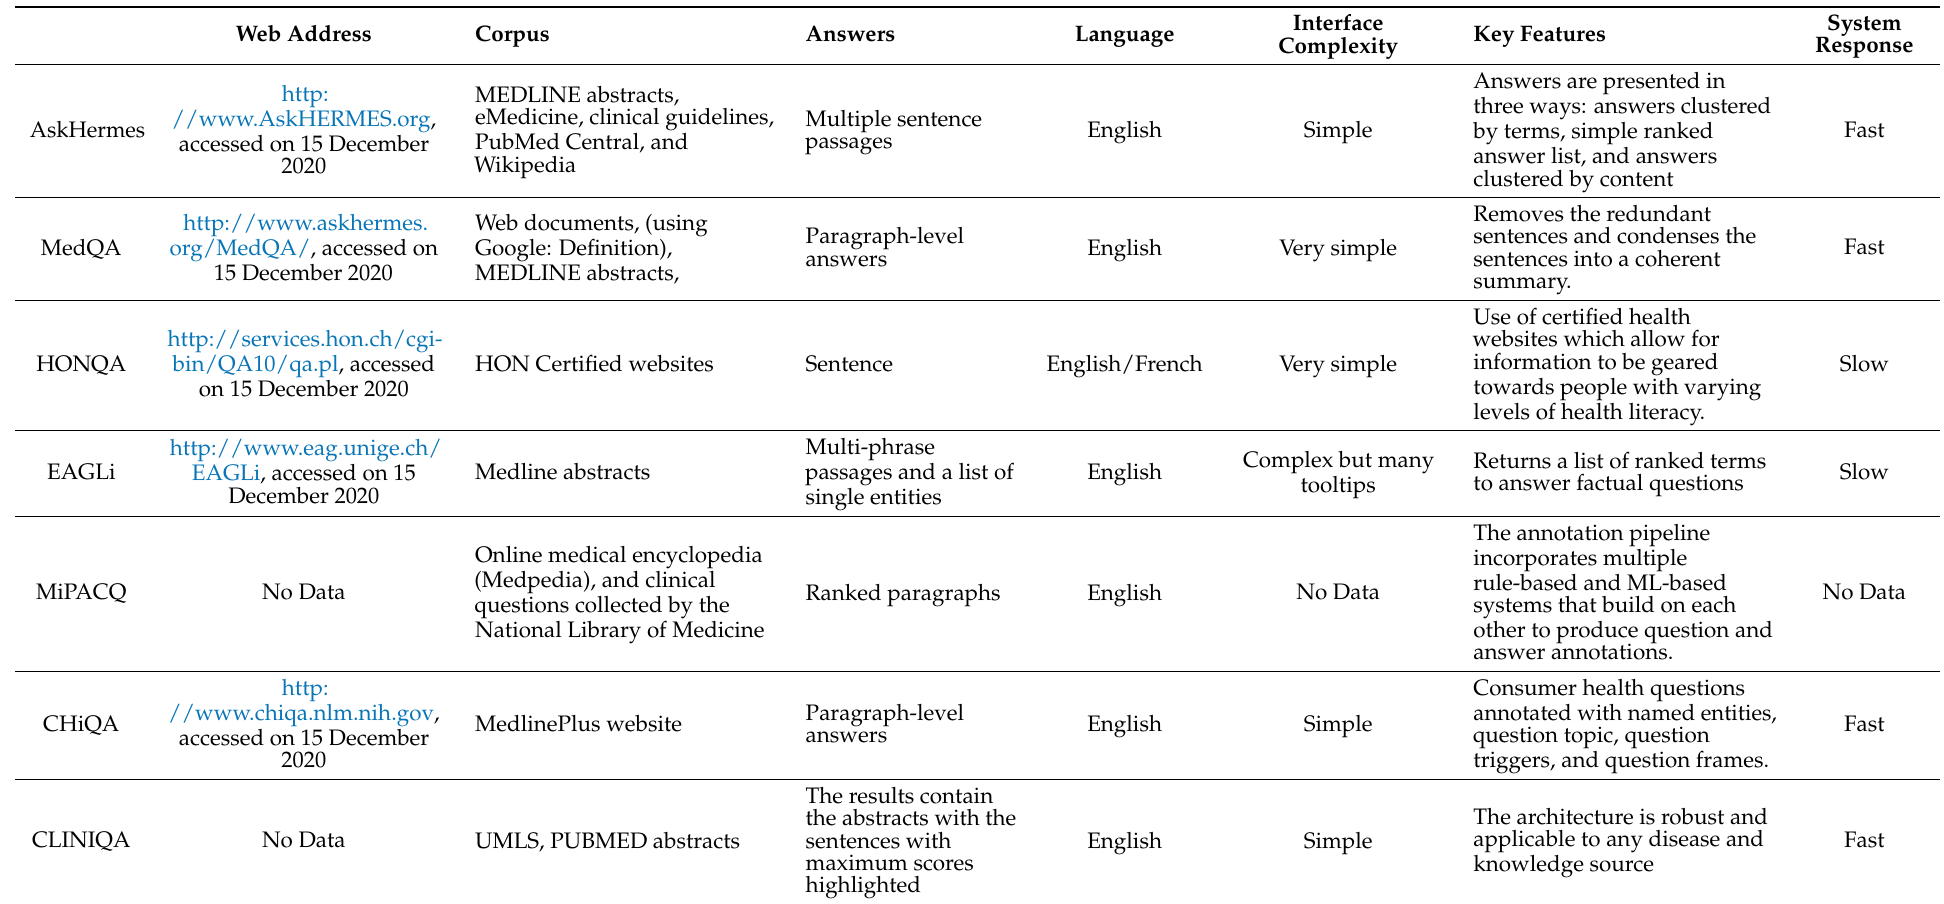
Table 1. Comparison of different Medical